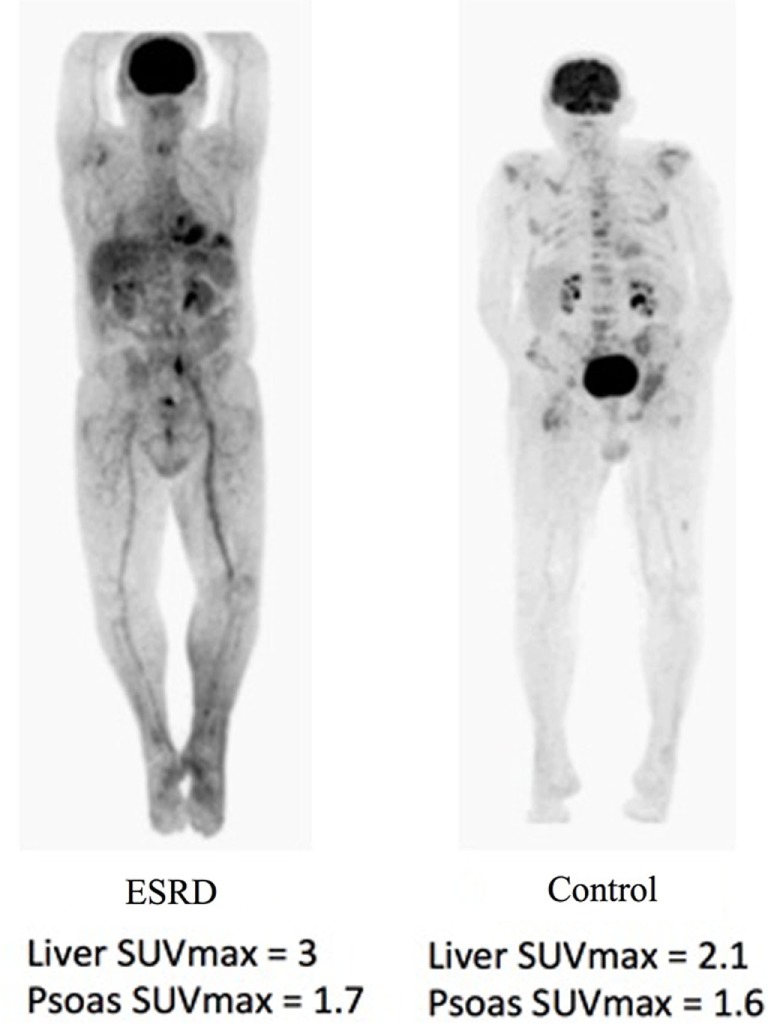
In a typical patient, the PET/CT will show an accumulation of the F18-FDG marker in areas that consume the most glucose, as well as the renal system in the body. As a result, areas of accumulation appear in the brain, kidneys, and bladder. The brain consumes much of the glucose and the kidneys filter the marker to the bladder. In the patient with renal failure, due to the slower filtration rate of blood, the areas of uptake seem to be increased within the soft tissue.